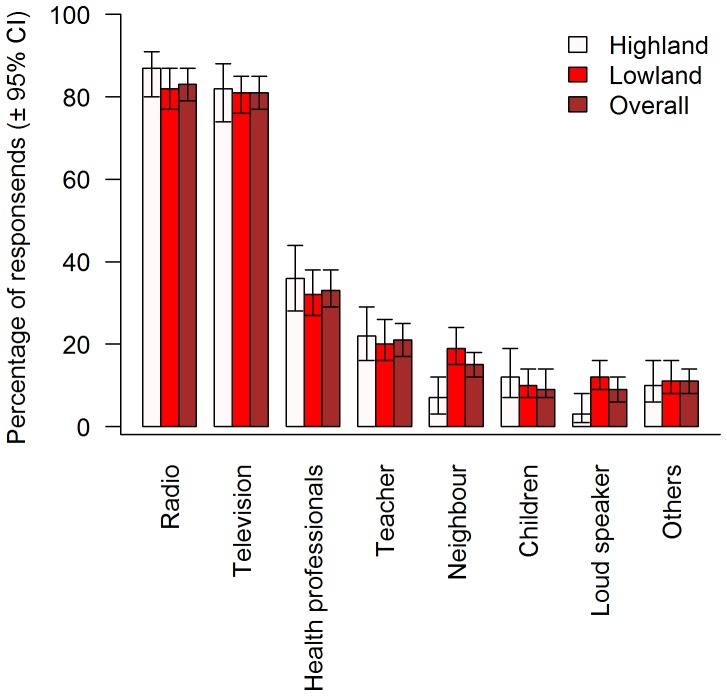
Sources of information on dengue fever.Error bars represent 95% confidence intervals.